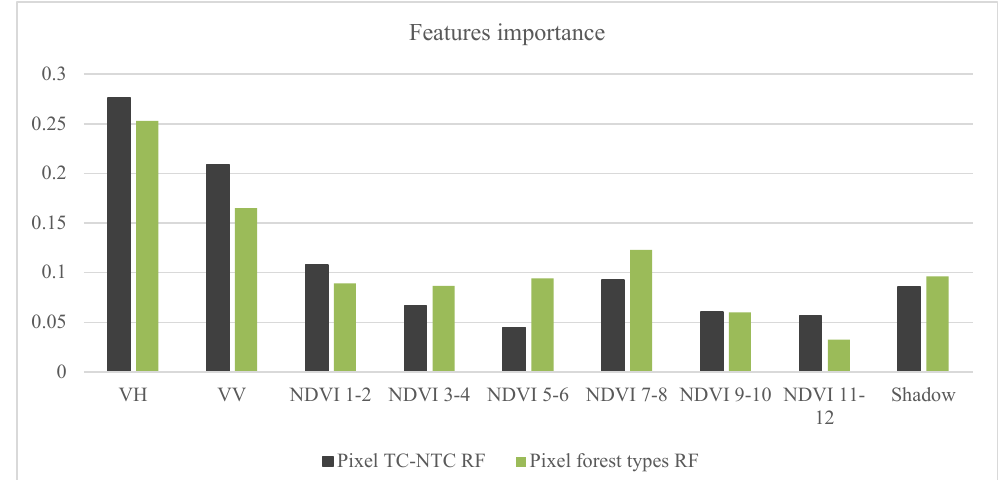
Figure 10. Features’ importance for two classifications in the “pixel” approach.